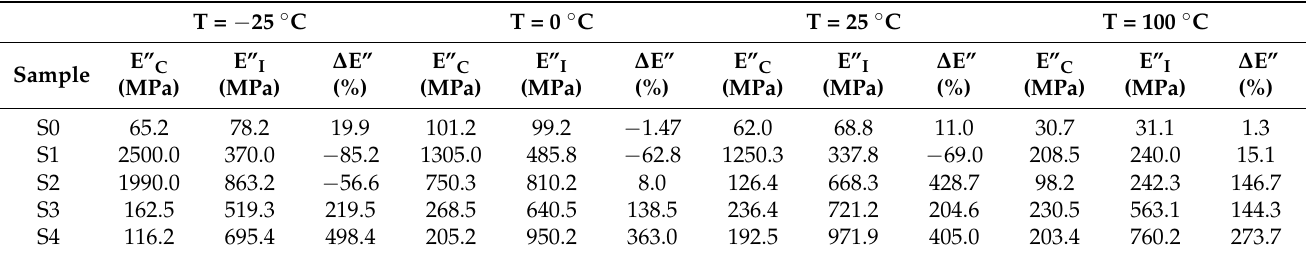
Table 6. Loss Modulus (E”) obtained from the indicated molded compounds obtained under Com- pression (E” C ) and Injection conditions (E” I ) for the indicated